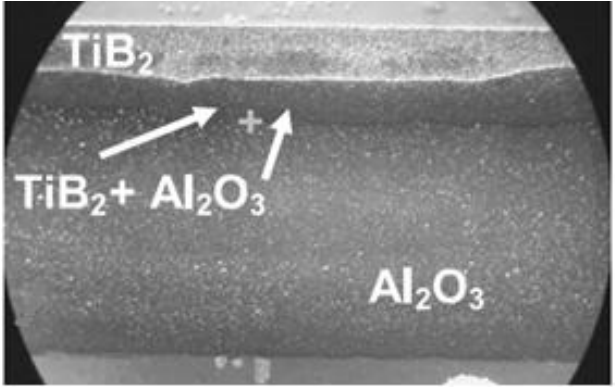
O and TiB 2 3 2